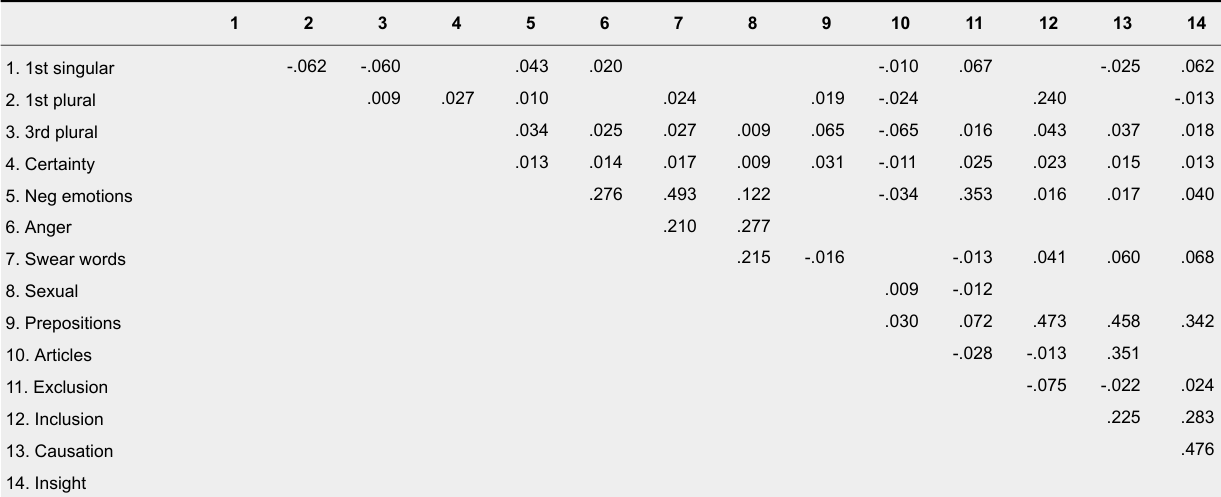
Mean Correlations Over Participants Between all LIWC Categories and Pronoun Use, (n = 11751)